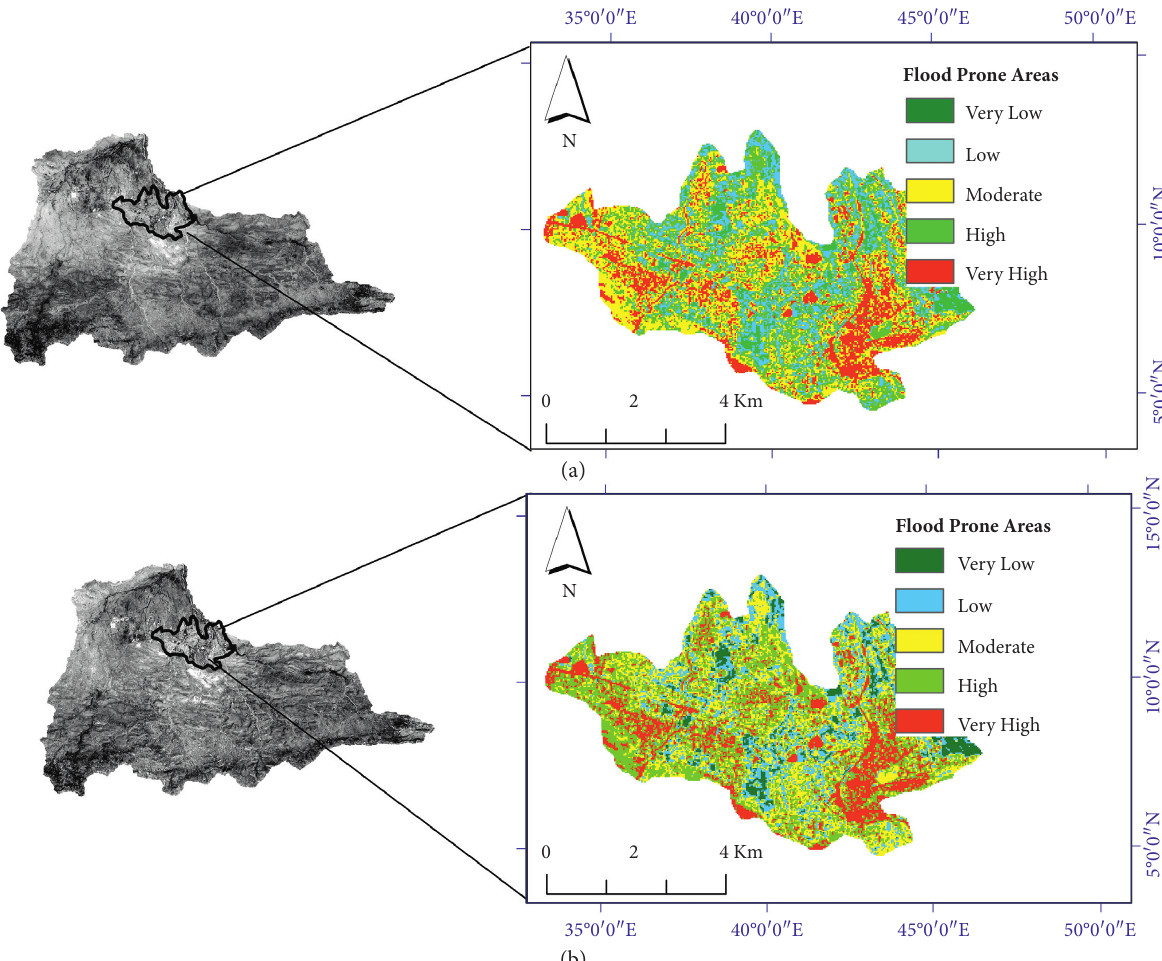
Figure 8: Identified flood prone areas in Dire city: (a) flood events and (b) ANN